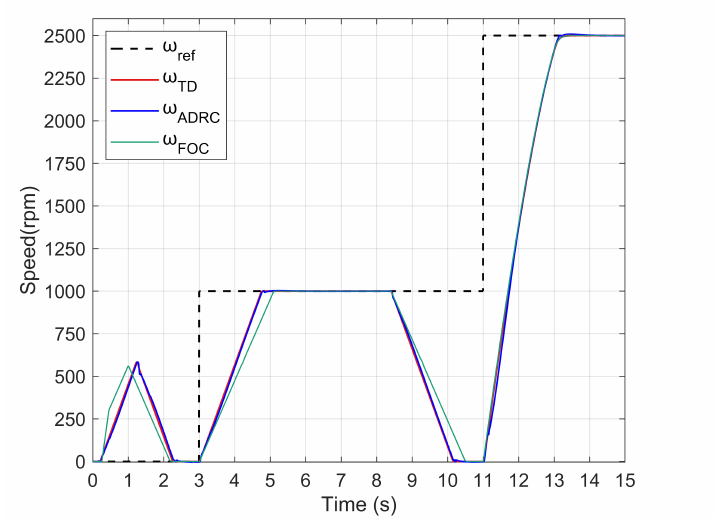
Figure 8. The actual speed of the improved ADRC system and the PI + FOC system.